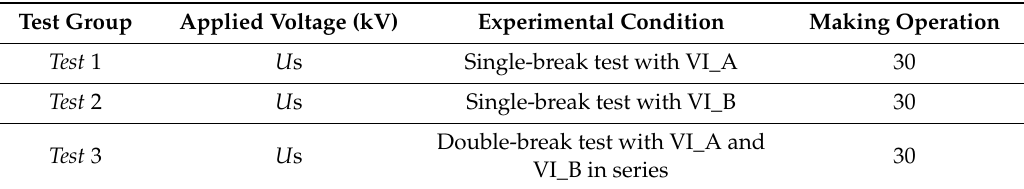
Table 1. Experimental